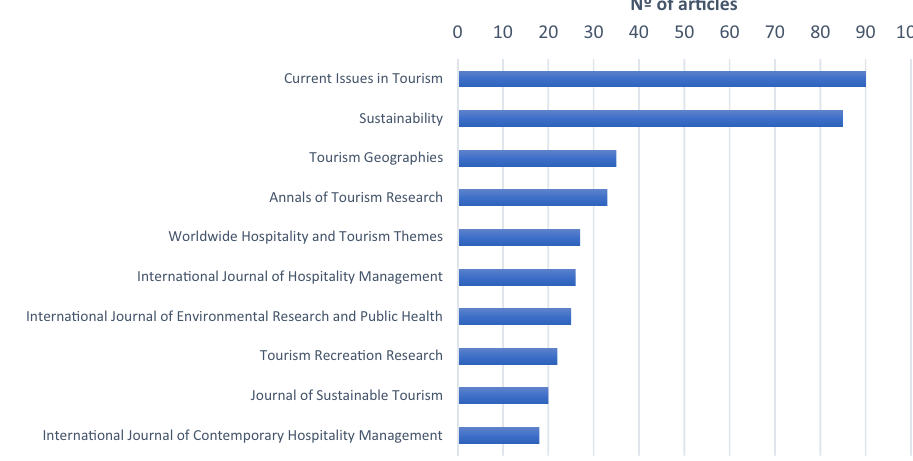
Fig. 6 Journals. Top 10 most published